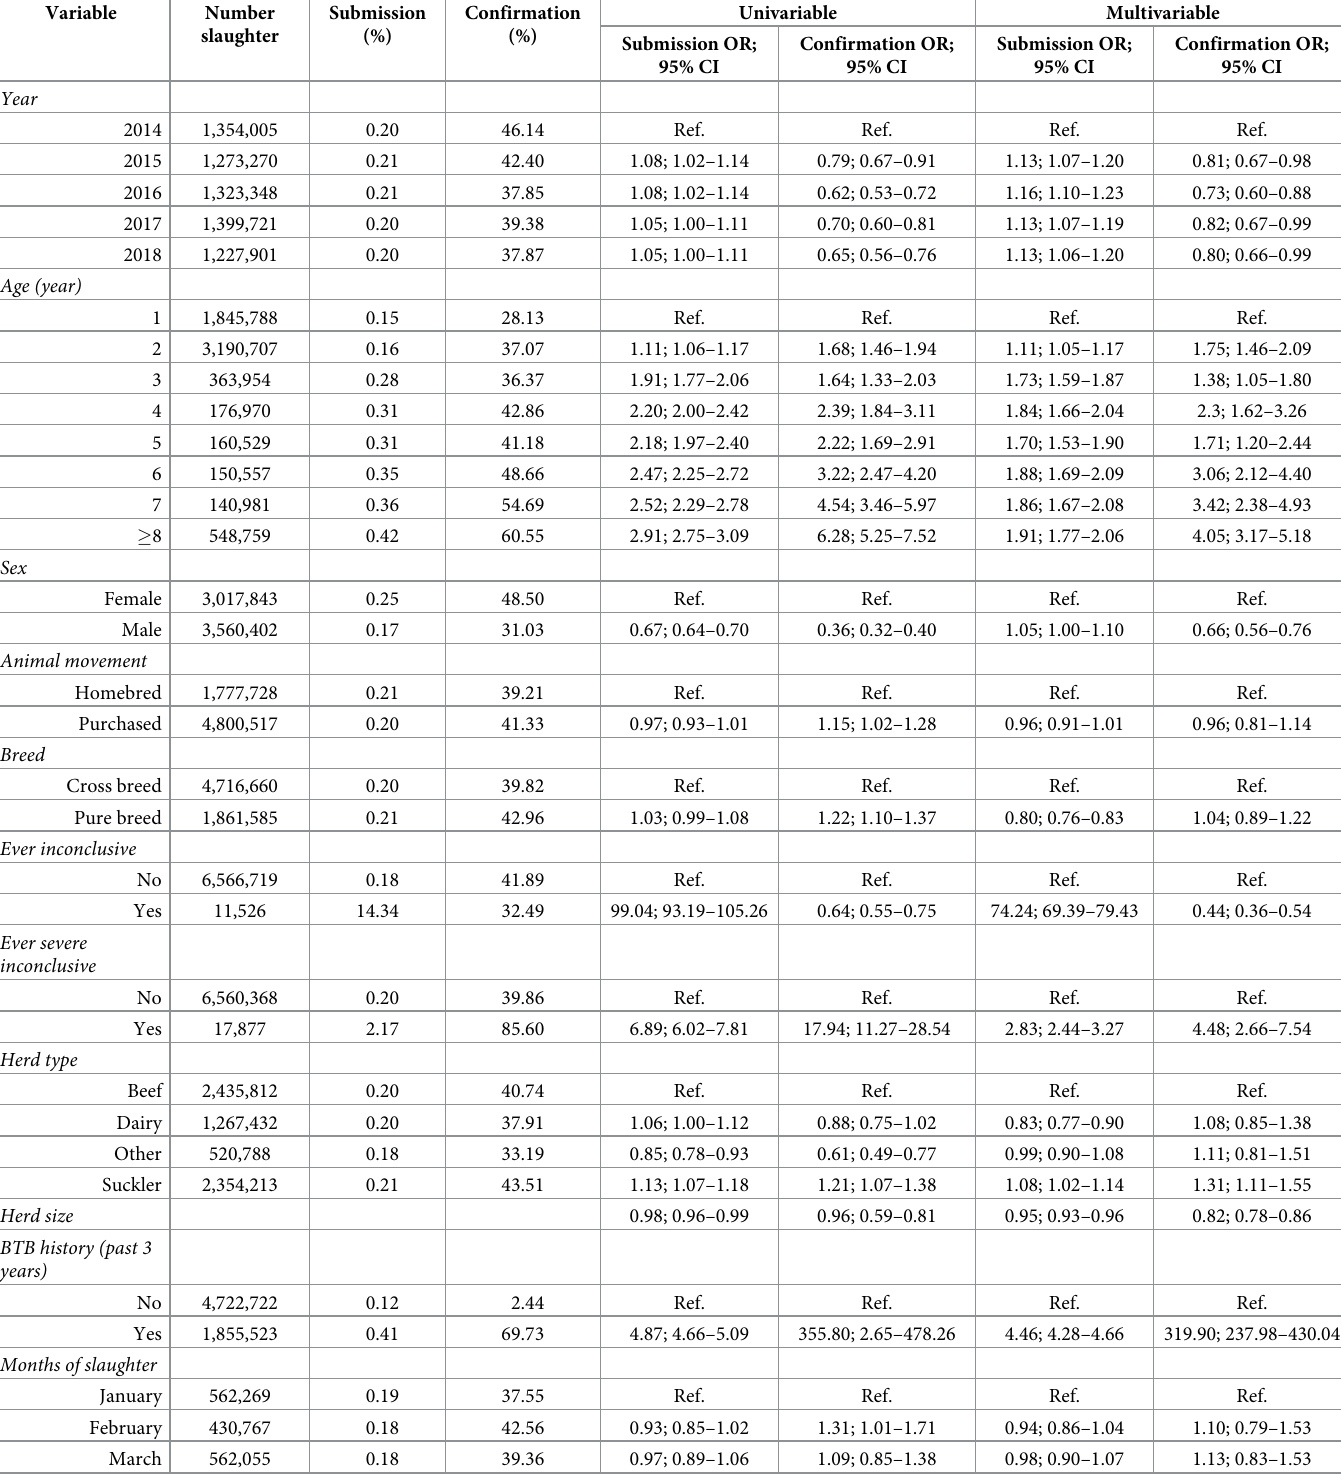
Table 3. Univariable and multivariable (adjusted for covariates and random herd effect) logistic regression results of submitted (n = 6,578,245) and confirmed (n = 13,337) bTB lesions from animals slaughtered in Irish factories in the period 2014–2018.